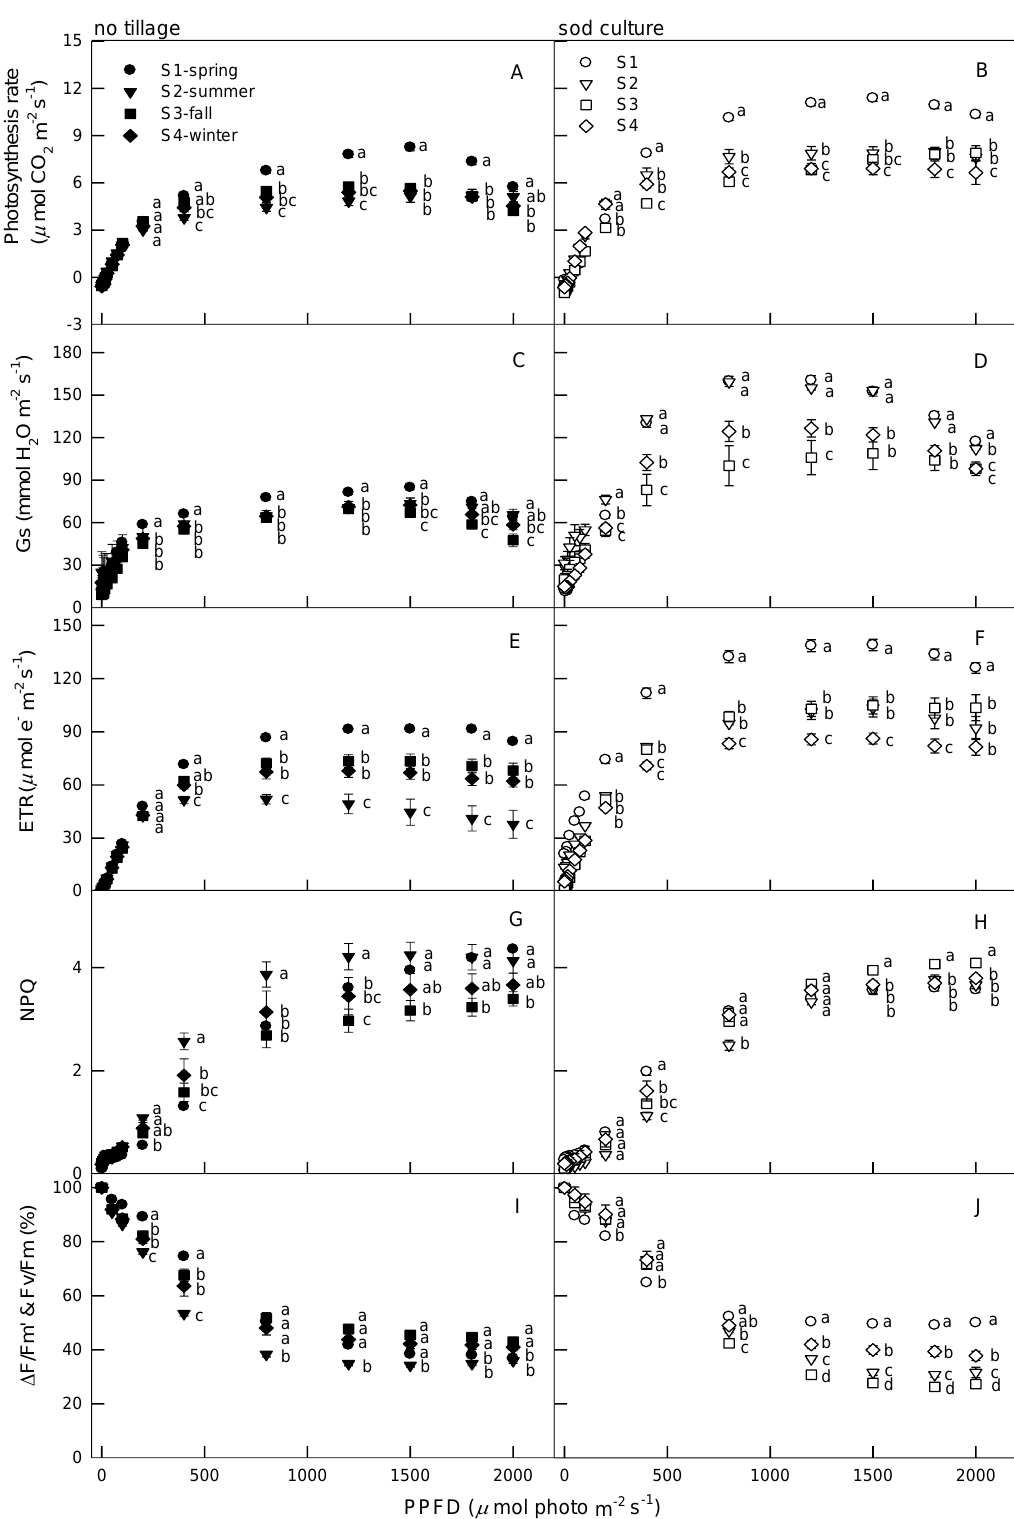
Figure 2. Comparison of NT and SC on Pn (panels A , B ), Gs (panels C , D ), ETR (panels E , F ), NPQ (panels G , H ), ∆ F/F’m, and Fv/Fm (panels I , J ) of citrus grown in four seasons (S1–S4) monitored from June 2019 to May 2020. Data are mean ± standard error, and each point represents the mean of five leaves. Different letters indicate significant differences in Tukey’s HSD analyses over four seasons ( p < 0.05).